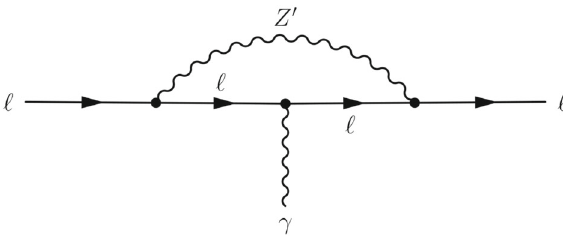
Fig. 1 The one-loop Z (cid:2) contribution to the anomalous magnetic moment of a charged